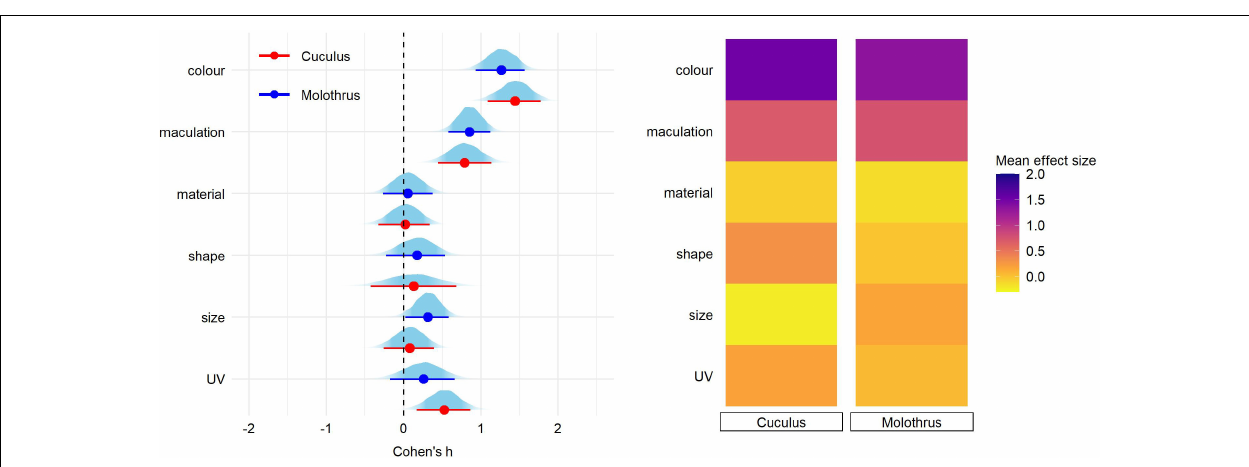
FIGURE 4 | Predicted effect size for egg trait types in hosts of Cuculus and Molothrus parasite species. On the left, for each trait type we show the parameter distribution with its median (dot) and 89% credible interval (lines). On the right, the median effect sizes are plotted as a heatmap for each trait type separated by parasitic lineage